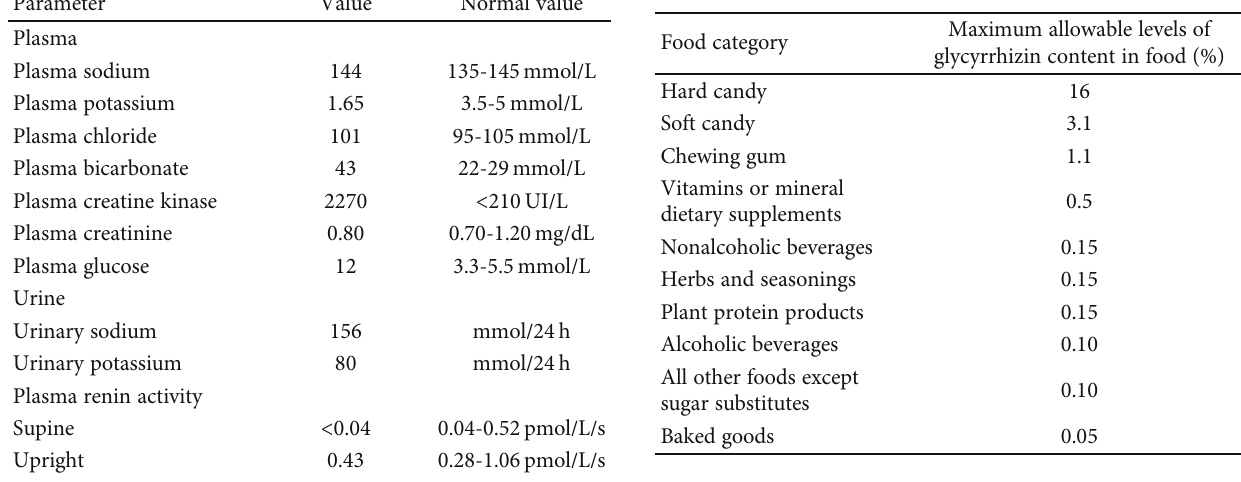
Table 2: Limitations for the use of liquorice and its derivatives in foods.